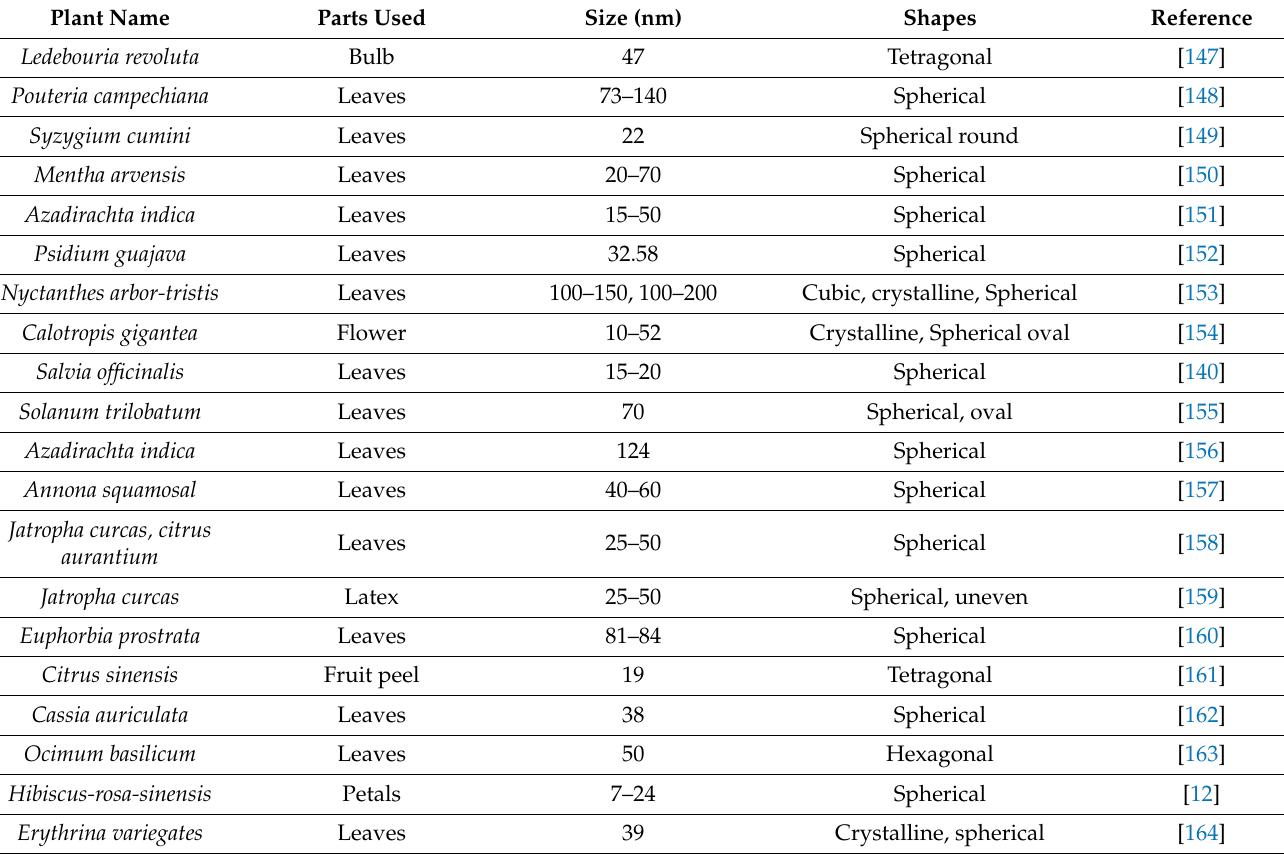
Table 4. Plant-assisted synthesis of titanium